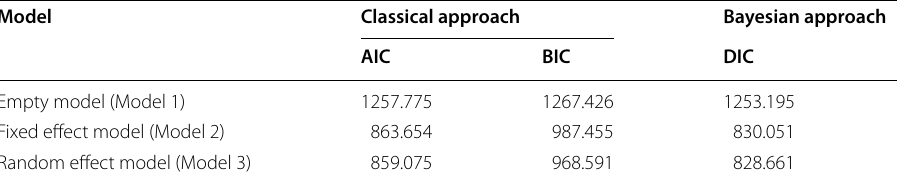
Table 5 Model comparison